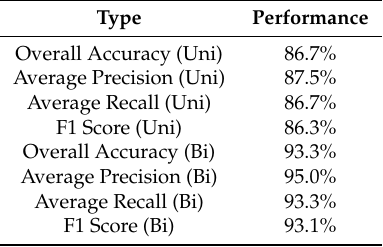
Figure 10. Confusion matrix of the two-stacked bidirectional LSTM RNN model. Table 2. Classification Performance of the Bidirectional & Unidirectional LSTM RNNs.